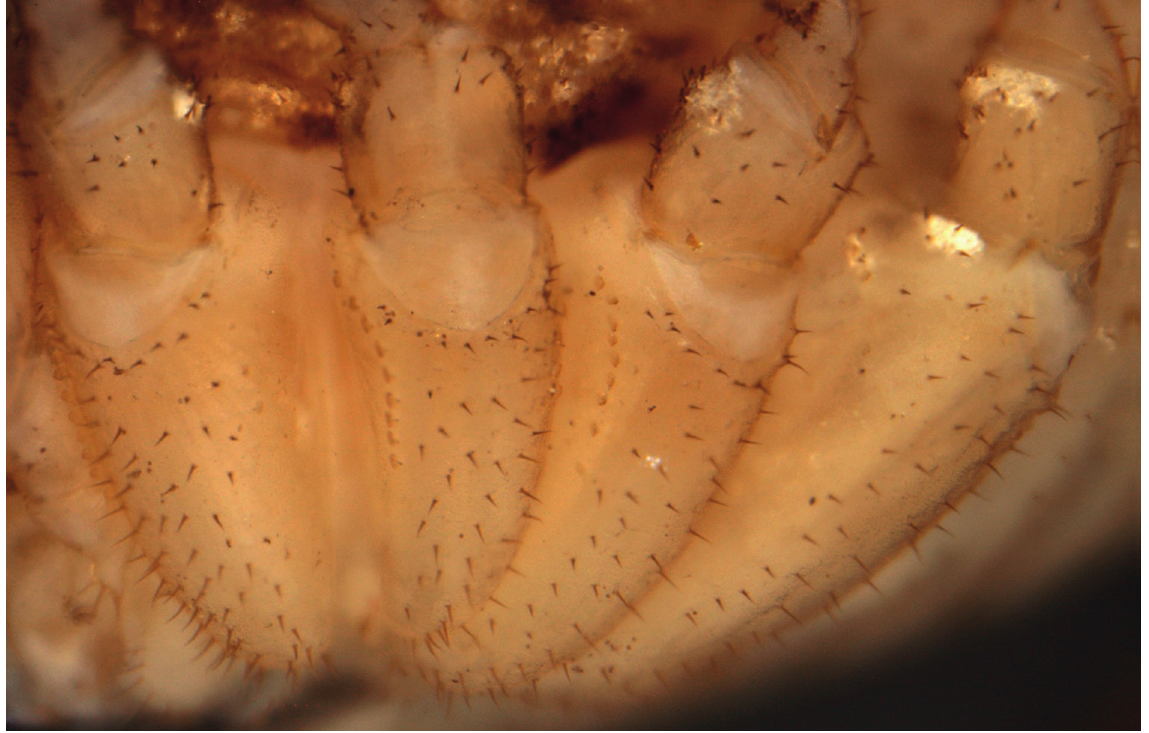
Fig. 2. Leiolima iberica gen. et sp. nov. Lateral view of the male holotype (MNCN 20.02/17372) (left is front side), showing coxae I to IV with coxal denticle rows.